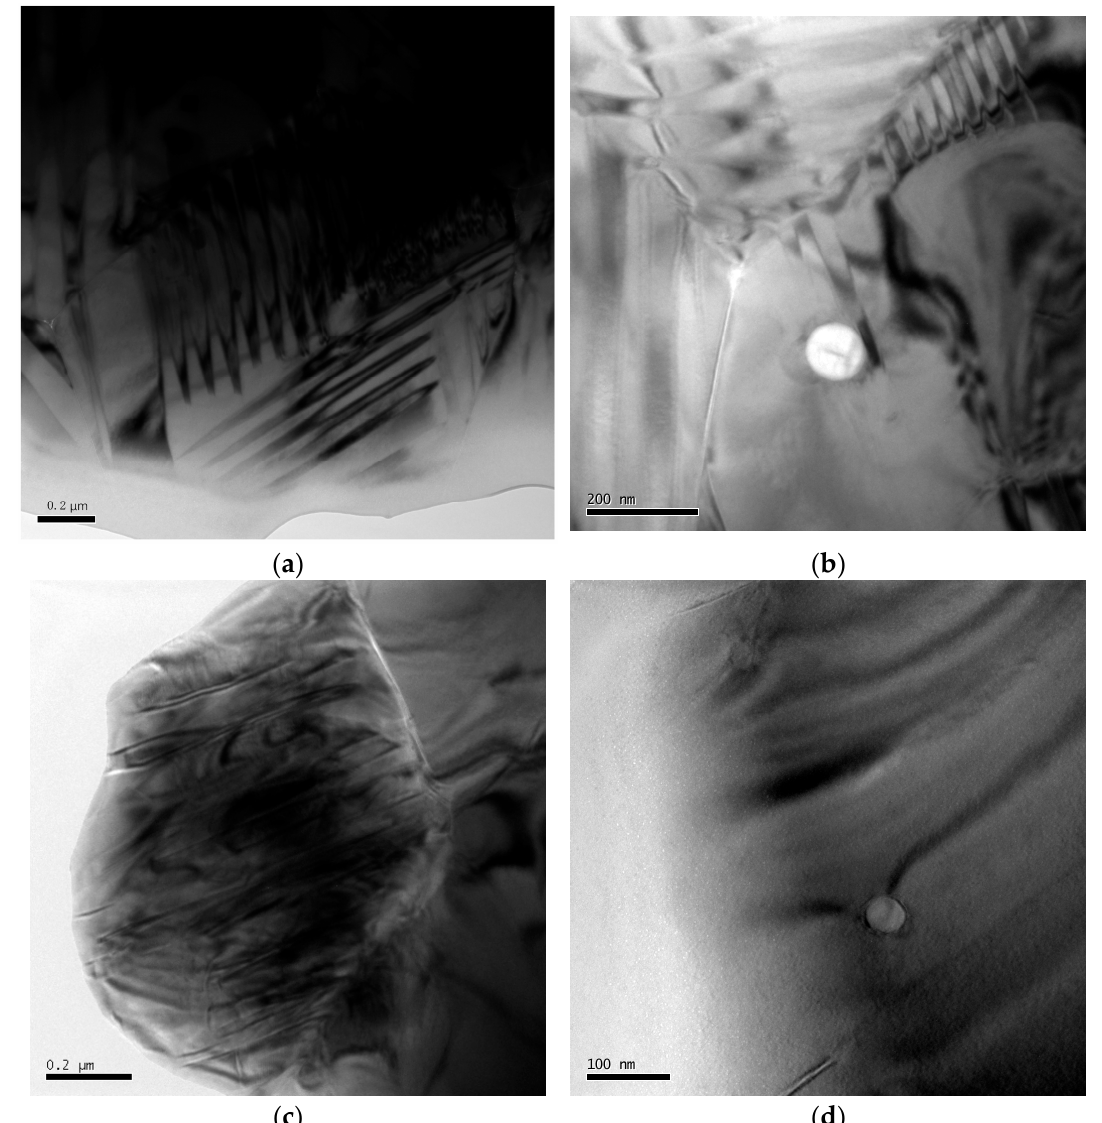
Figure 7. TEM images of ferroelectric domains in PZT/ZrO 2 (PZTN, x = 0.04) nanocomposite ceramics sintered at 1260 °C for 2 h. ( a ) 90° domain; ( b ) Effects of ZrO 2 on 90° domain; ( c ) 180° domain; ( d ) Effects of ZrO 2 on 180° domain.